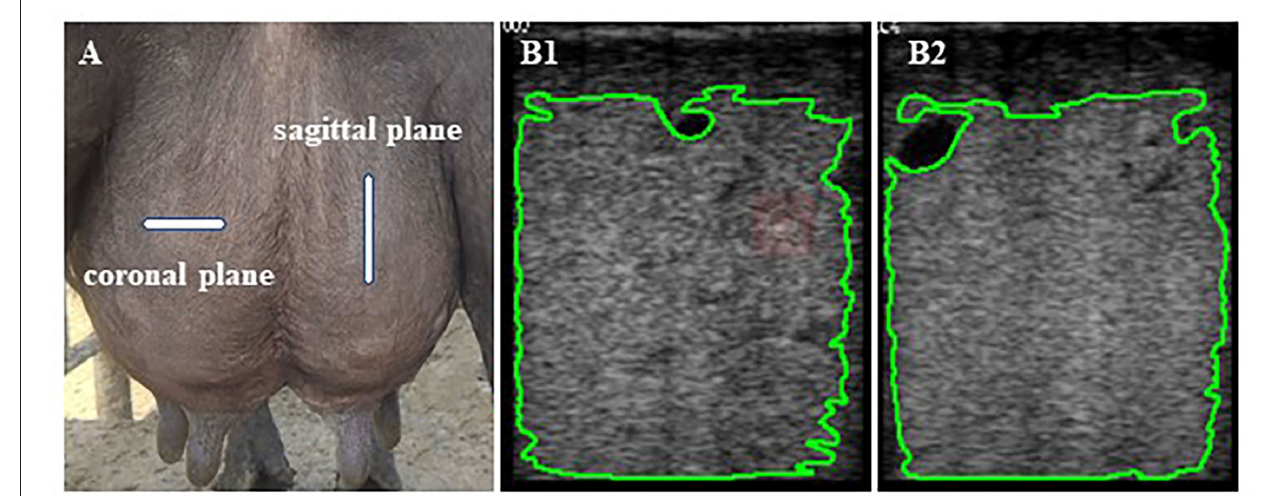
FIGURE 1 | (A) The probe is located on the coronal and sagittal planes surfaces of the udder quarters. (B1,2) The mammary parenchyma echotexture of the selected area of coronal (B1) and sagittal planes (B2) excluding the areas with lactiferous ducts, gland cisterns, and visible blood vessels formations was calculated using Image-Pro Plus